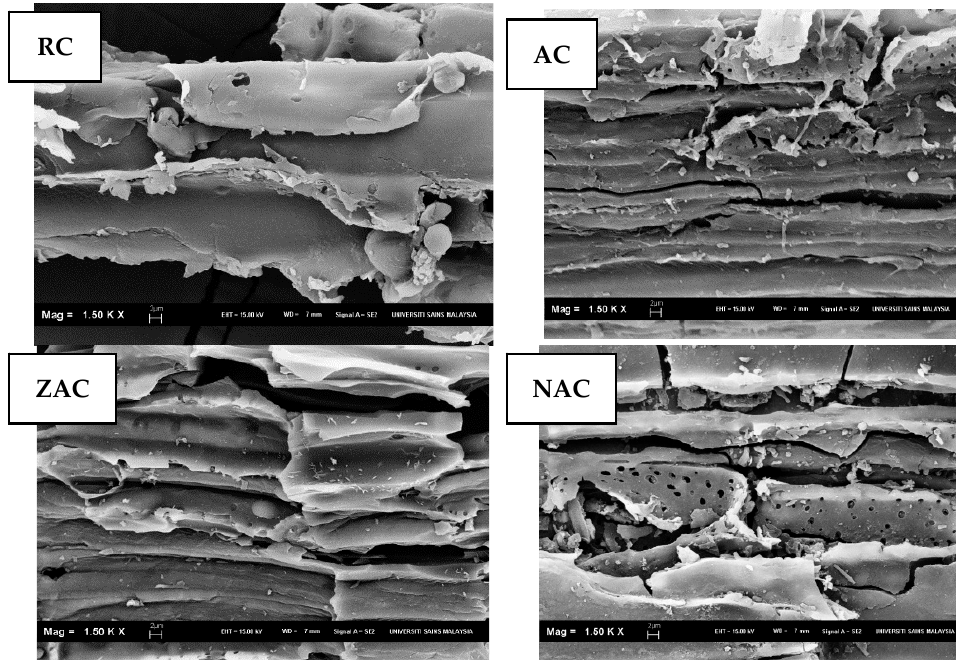
Figure 2. The SEM images of cassava stem adsorbent samples (1500× magnification).